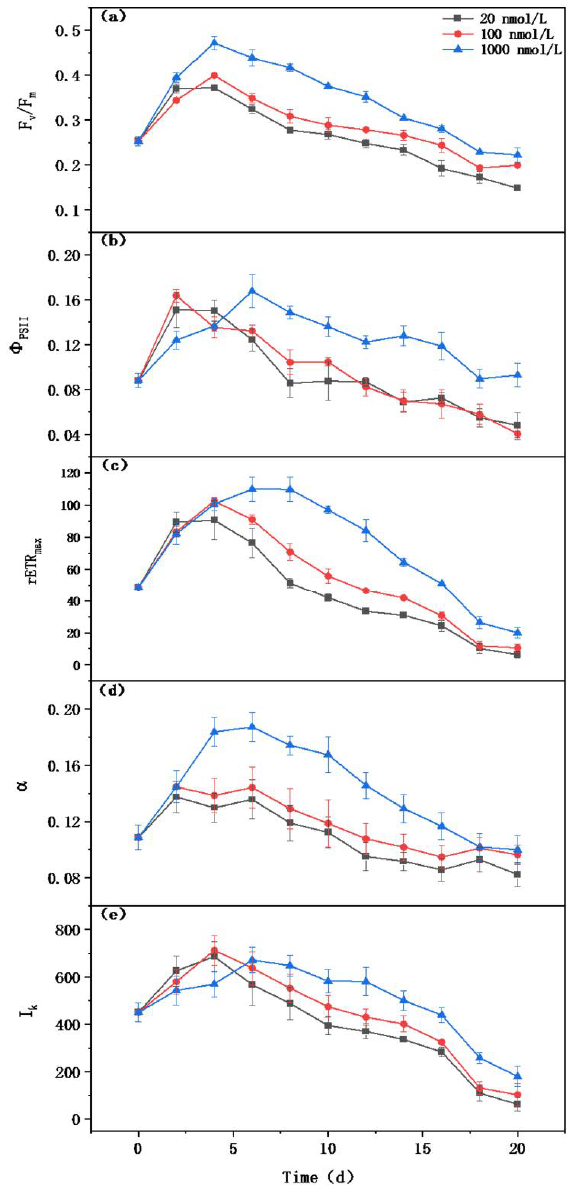
Figure 3. The effect of different iron concentrations on the photosynthetic efficiency of Microcystis aeruginosa ( a ) F v /F m , the maximum photosynthetic efficiency of PSII; ( b ) Φ PSII , the actual photosyn- thetic efficiency of PSII; ( c ) rETR max , the maximum electron transfer rate; ( d ) α , initial slope; ( e ) I k , saturated light intensity.